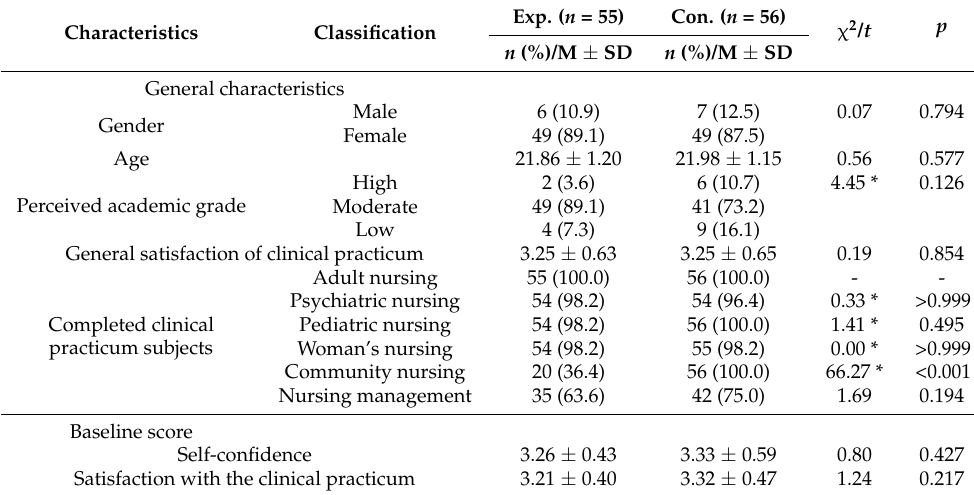
Table 1. Homogeneity test between two groups ( n = 111).